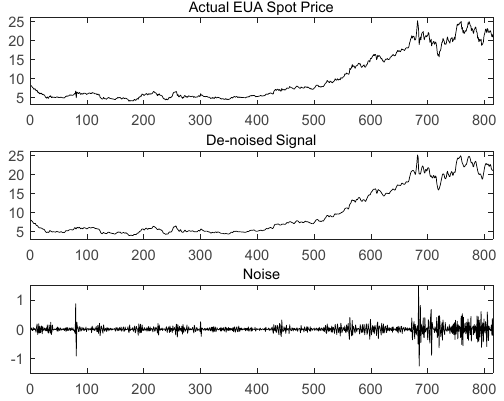
Figure 7. Decomposed results of EUA spot price by wavelet transform (WT).